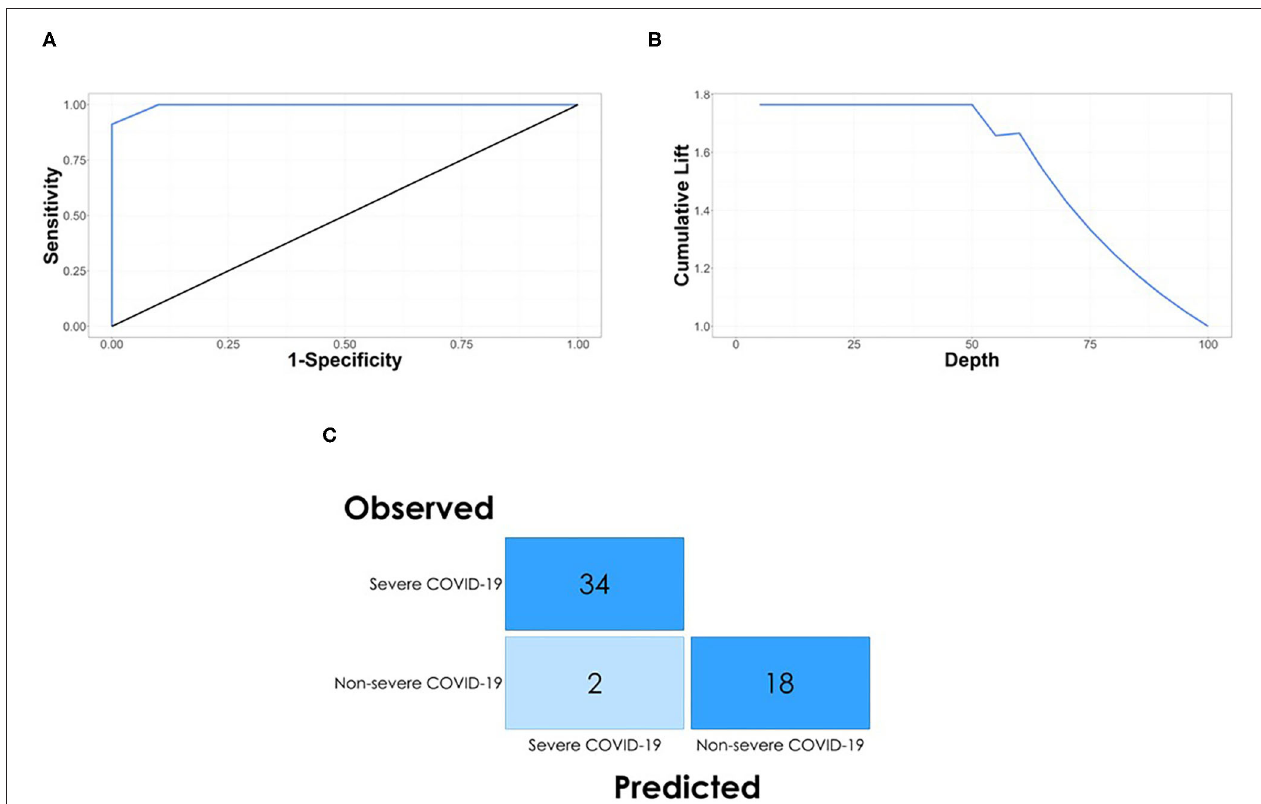
FIGURE 3 | Model performance. (A) The ROC curve plot with AUC 0.9956 for the decision tree model indicates that the hematological parameters can be used as predictors for the severity of COVID-19 on the day of positive swab. (B) The model achieved a cumulative lift of 1.76 at the 10% quantile, indicating that the model identifies almost two times more severe COVID-19 patients at the day of positive swab than expected with random selection. (C) The confusion matrix for the model shows that all of the severe COVID-19 patients and 18 of 20 non-severe COVID-19 patients were correctly classiified by the decision tree model based on three hematological